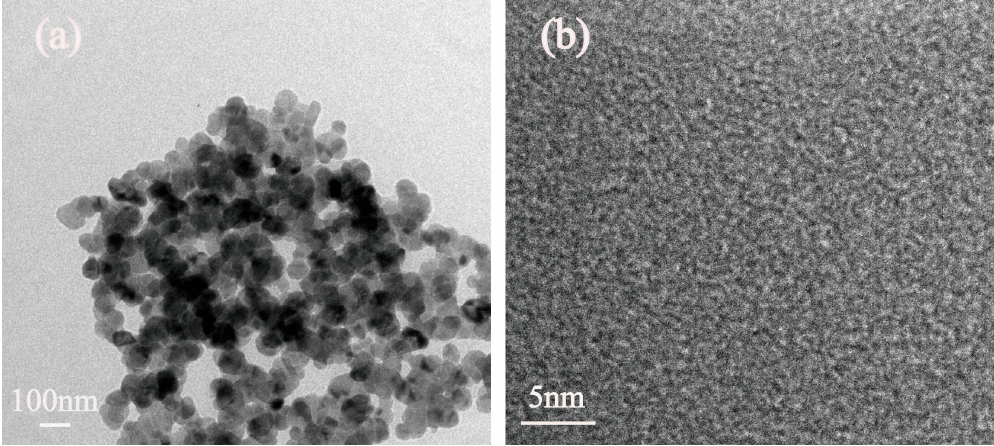
Figure 6. ( a ) Transmission electron microscope (TEM) ( b ) High resolution transmission electron Figure 6. (a) Transmission electron microscope (TEM) (b) High resolution transmission electron microscopy (HRTEM) images of microscopy (HRTEM) images of MCs-2.